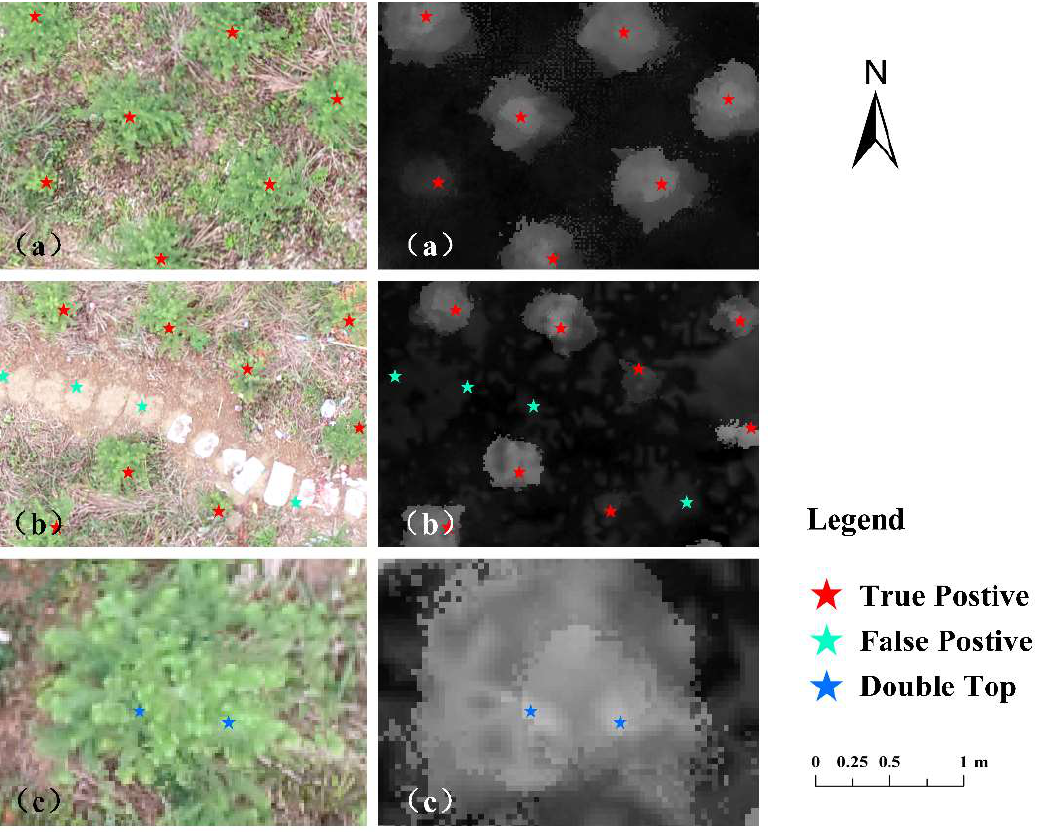
Figure 11. Local maximum value algorithm extract tree crown top; figure ( a ) shows red stars as true positives; figure ( b ) shows green stars as false positives; figure ( c ) shows blue stars as double tops. Tables 2 and 3 show the accuracy verification of the tree height. The average tree height in the research region was 2.35 m (excluding death and damage to young trees) through the divide-and-conquer and local maximum value methods. The performance of the test results (average accuracy = 88.49%; R 2 = 0.9462, RMSE = 0.3354) was marginally inferior to divide and conquer. The R 2 correlation was comparable, whereas the RMSE value was large; the average tree height in the research region was 0.28 m taller. Table 2. Accuracy verification of tree height in 2020 from DAC. 2020 Tree NO.